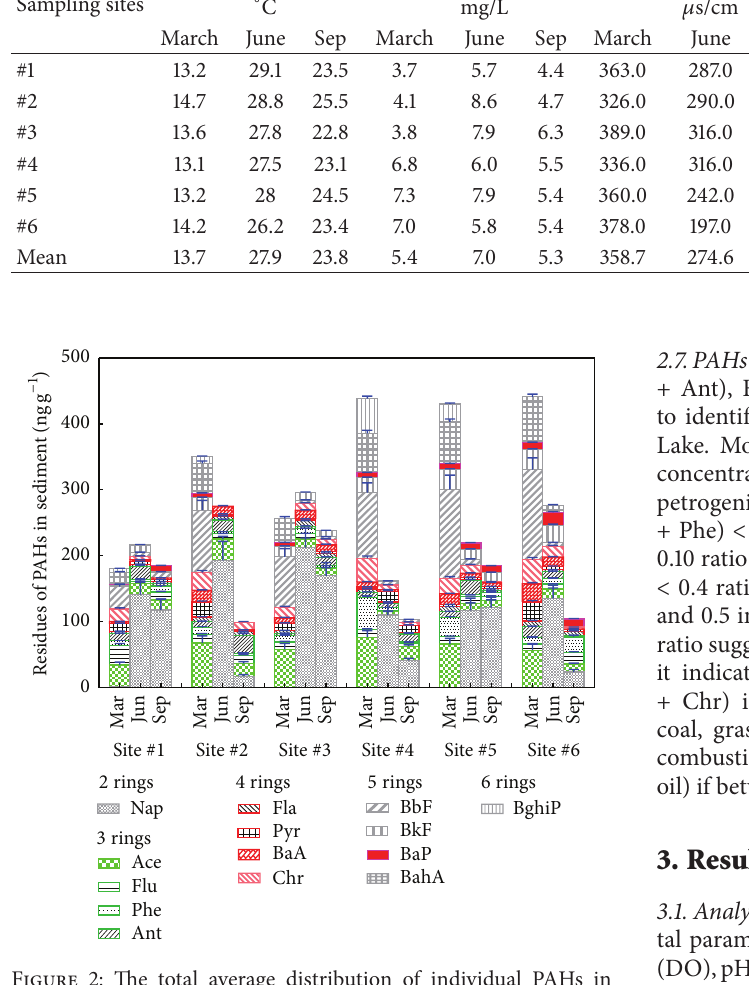
Figure 2: The total average distribution of individual PAHs in sediments from Changdang